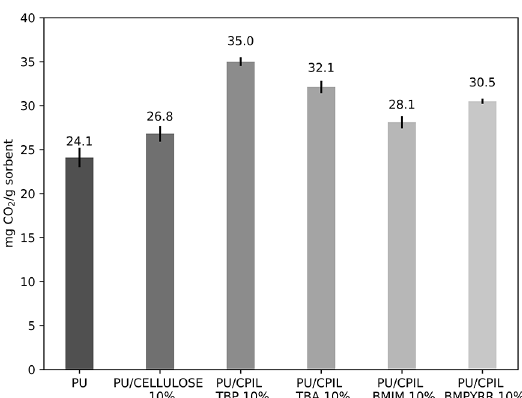
Figure 10. PU/CPIL-TBP composites CO at 0.1 MPa and 298.15